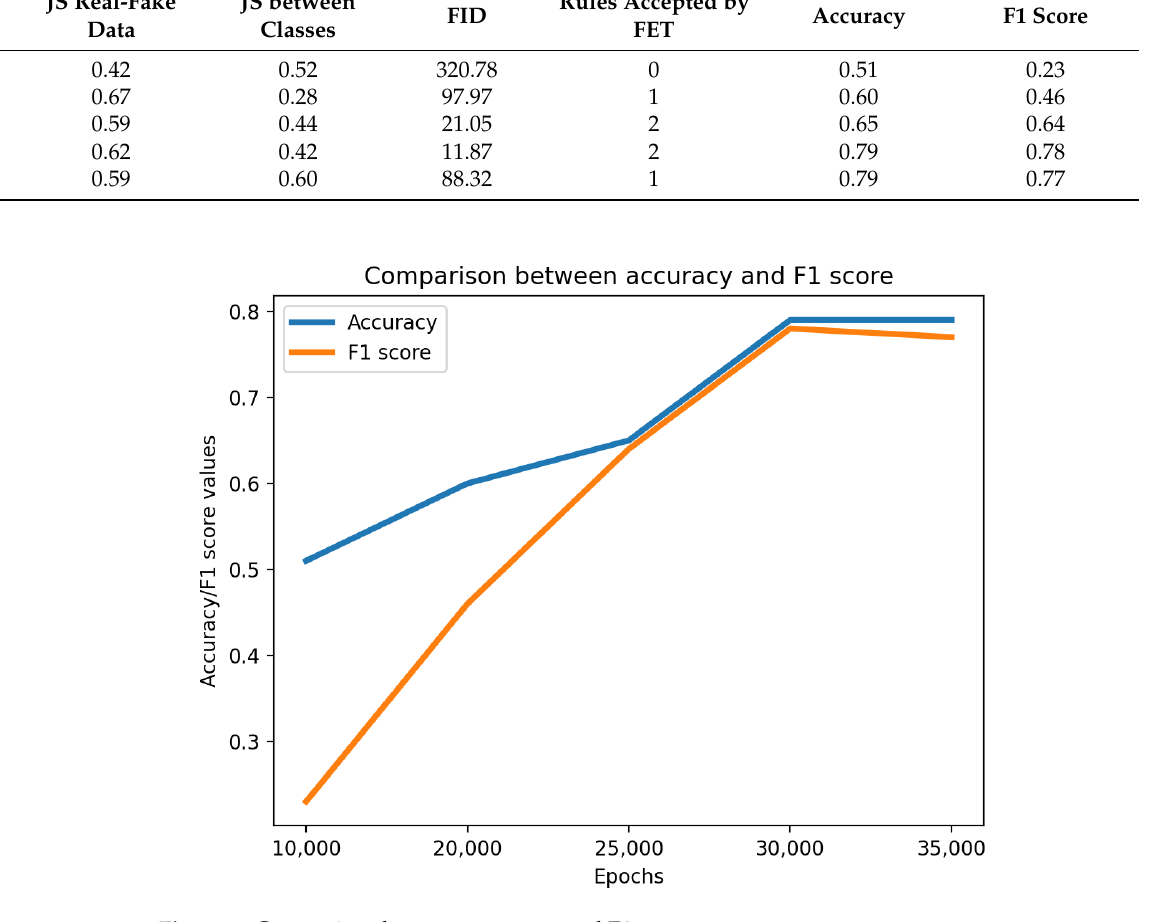
Figure 3. Comparison between accuracy and F1